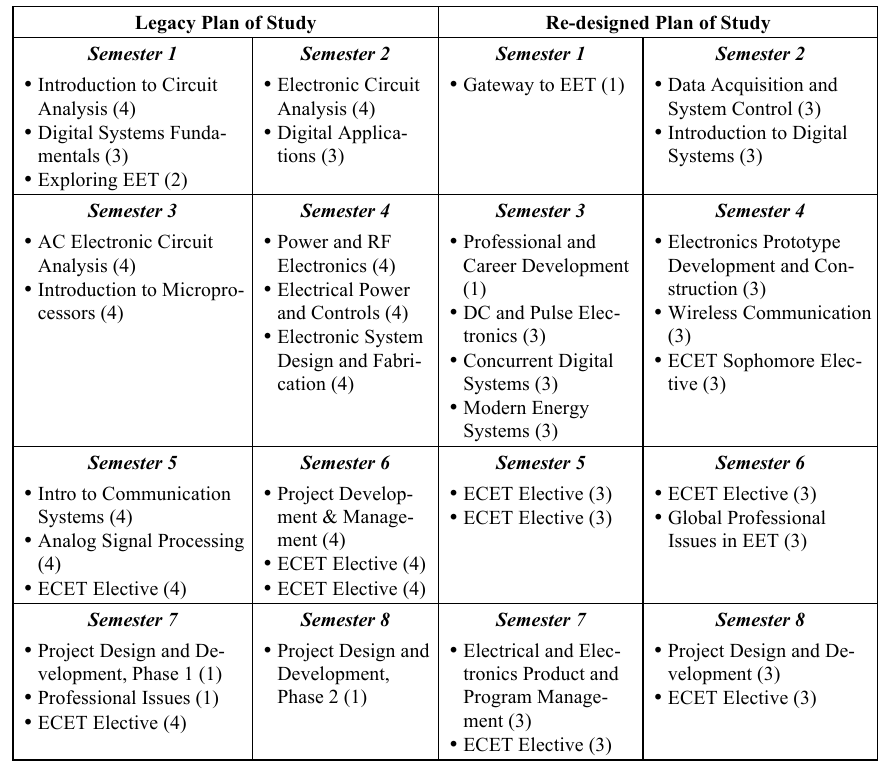
Table 2. Comparison of Legacy and Re-designed Plans of Study for